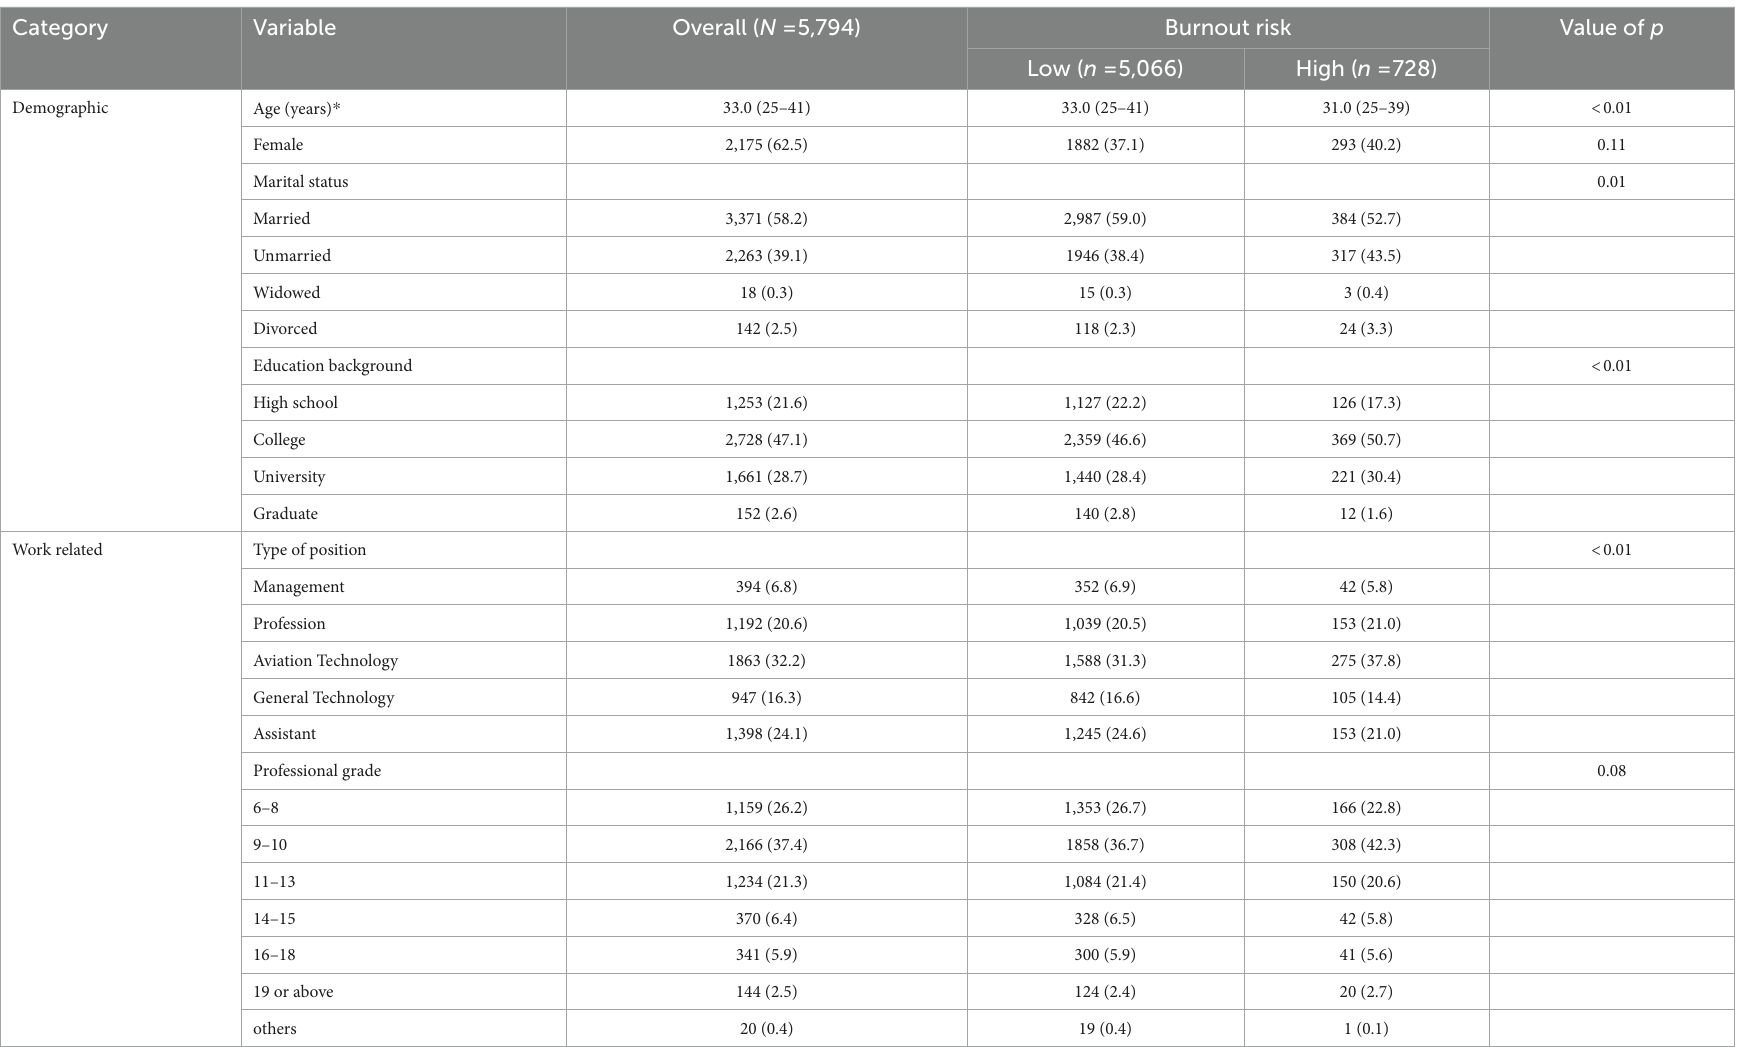
TABLE 1 Characteristics of participants categorized by burnout risk.